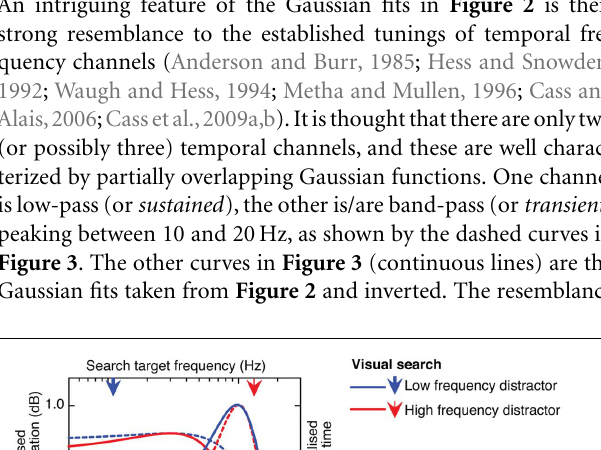
Gaussian fits taken from Figure 2 and inverted. The resemblance